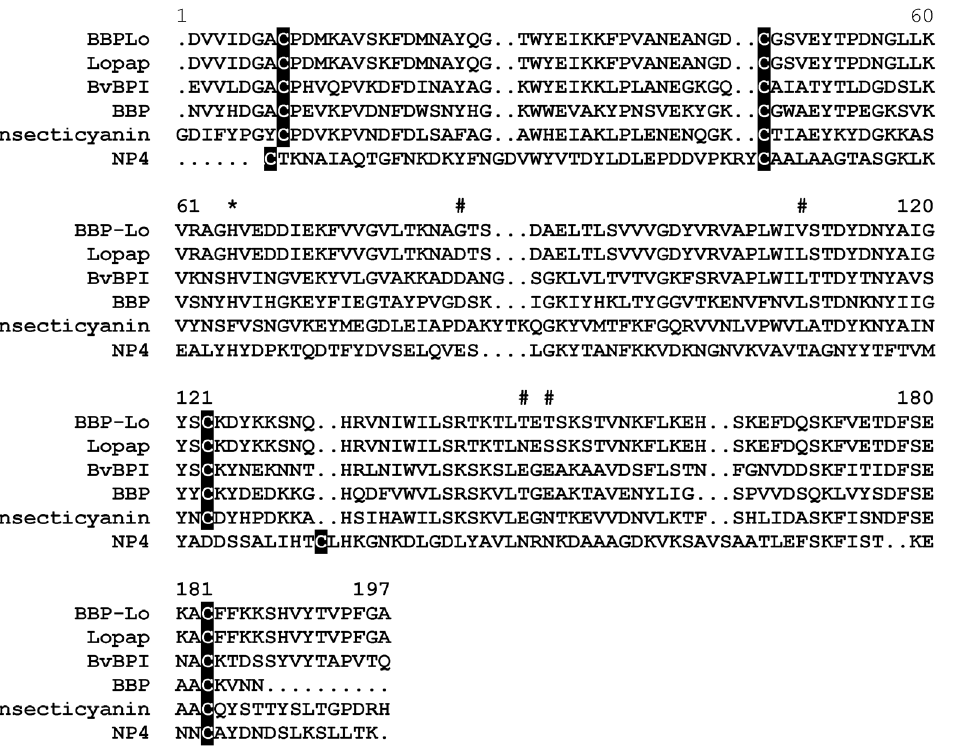
Figure 2. Alignment of L.obliqua BBPLo with lopap from L.obliqua (gi|59709575), biliverdin-binding protein I (BvBPI) from Samia cynthiaricini (gi|18857921), bilin-binding protein (BBP) from Pierisbrassicae (gi|1705433), insecticyanin from Manducasexta (gi|9716), and nitrophorin 4 (NP4) from R.prolixus (gi|3219833). Conserved cysteine residues are shaded in black, the binding pocket histidine residue is marked with an asterisk, and the amino acid positions differing between BBPLo and lopap are marked with hash symbols.